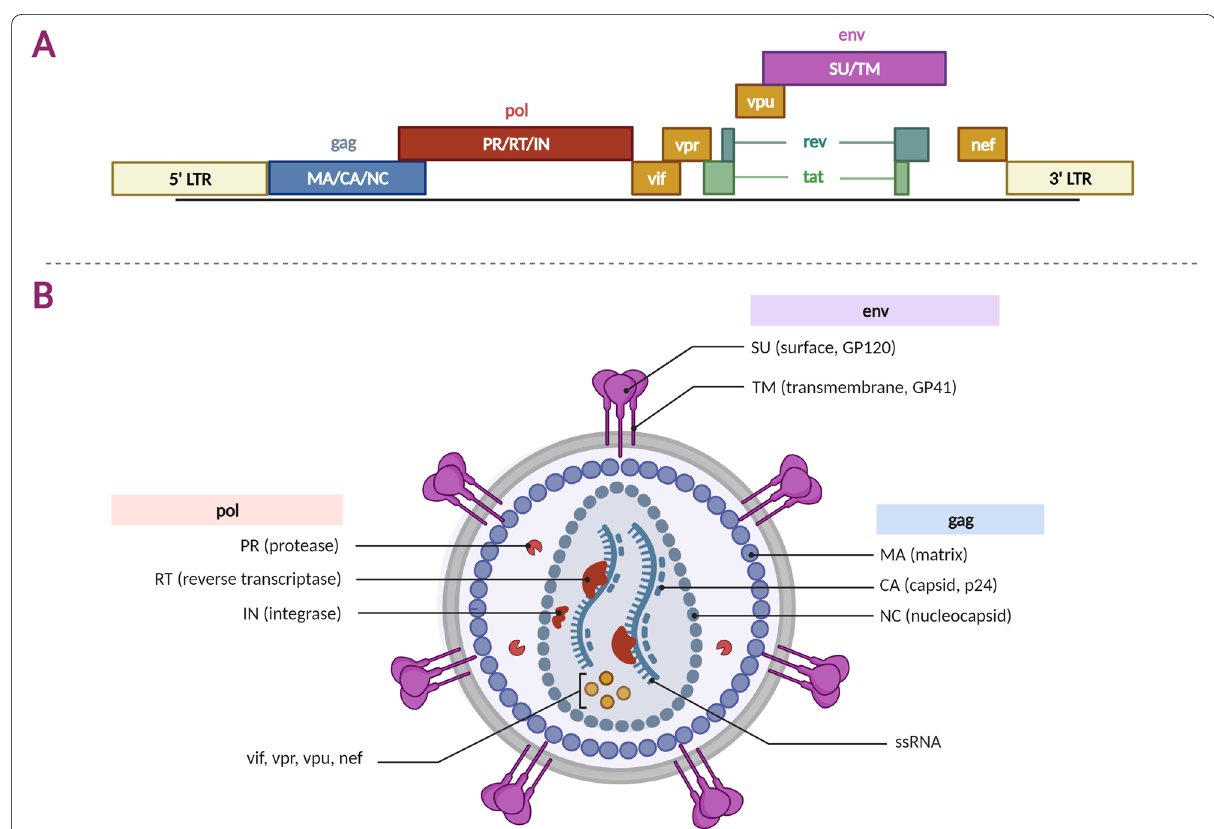
Fig. 1 The structure of HIV-1 virus. HIV-1 virus consists of several essential genes, including long terminal repeats (LTR), group-specific antigen (gag), DNA polymerase (pol), viral infectivity factor (vif), viral protein u (vpu), envelope (env), and negative regulatory factor (nef). a shows the HIV-1 genome, while b shows the HIV-1